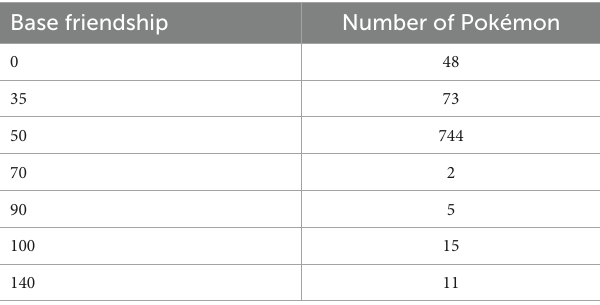
TABLE 1 Distribution of Pokémon per level of base